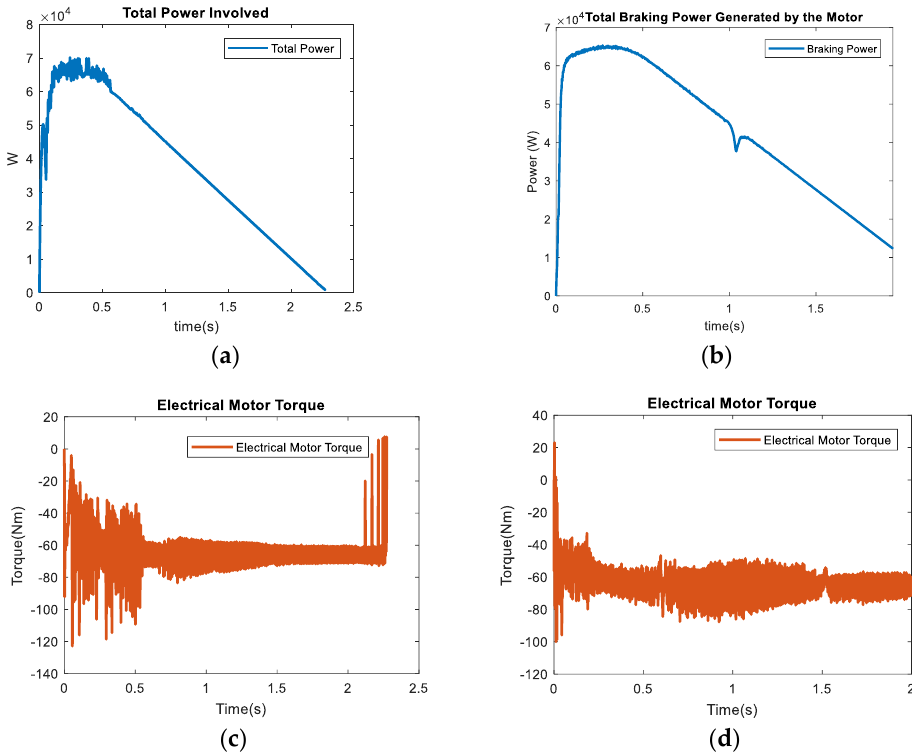
Figure 20. Total generated power by the two 30 kW motors and the associated braking torque for each motor for the BqZSI topology ( a , c ) and 3-level/SVPWM topology ( b , d ).